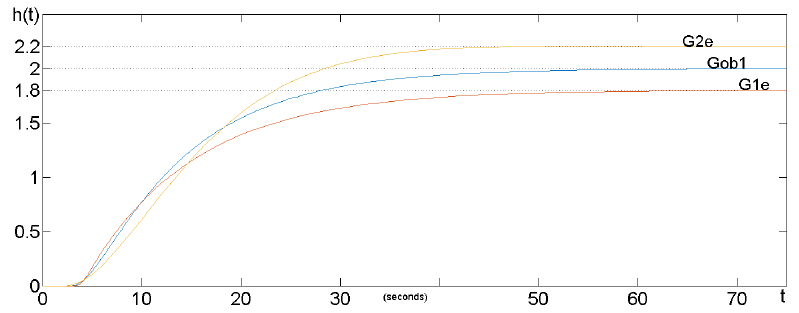
Figure 8. Step responses of the plant and models that were determined from inaccurate input data.